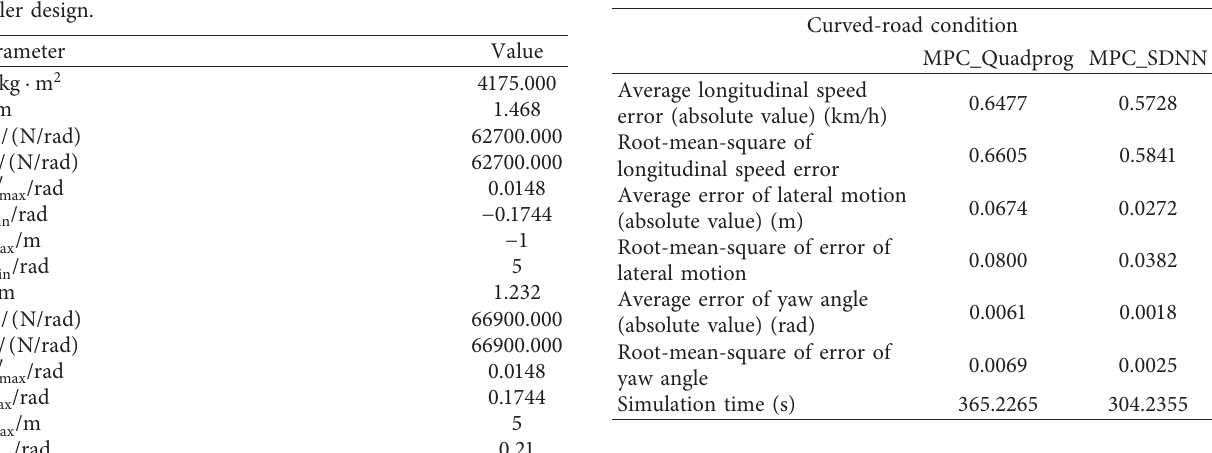
Table 18: Performance in the curved-road